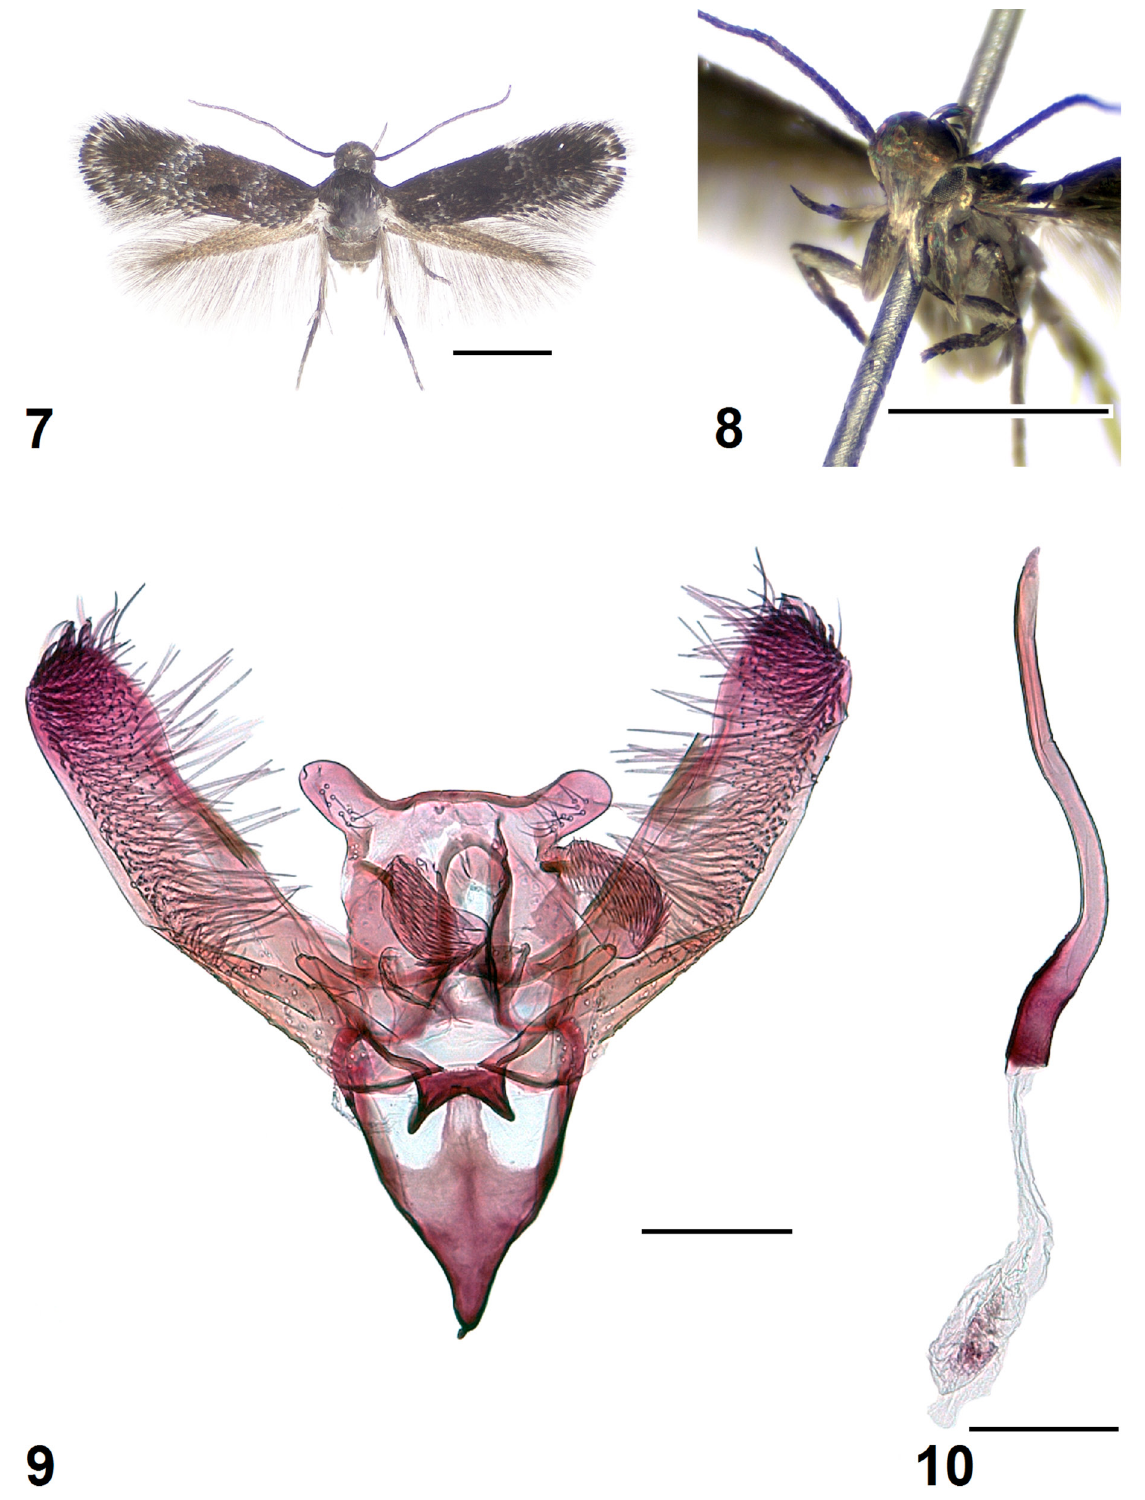
Figs 7–10. Elachista buszkoi Sruoga & Kaila sp. nov., holotype, ♂ (MZH VS1/2.04.19). 7 . Adult. 8 . Head, latero-frontal view. 9 . General view of male genitalia (phallus removed). 10 . Phallus. Scale bars: 7–8 = 1 mm; 9–10 = 0.1